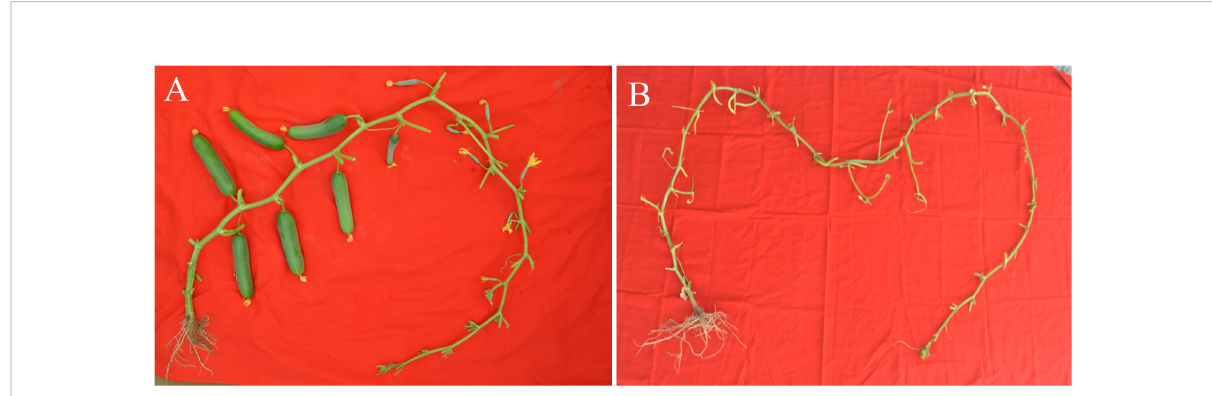
FIGURE 1 Fruit set in the contrasting parental lines (A) Pusa Parthenocarpic Cucumber-6 with parthenocarpic fruit development (B) Pusa Uday with no parthenocarpic fruit set under protected